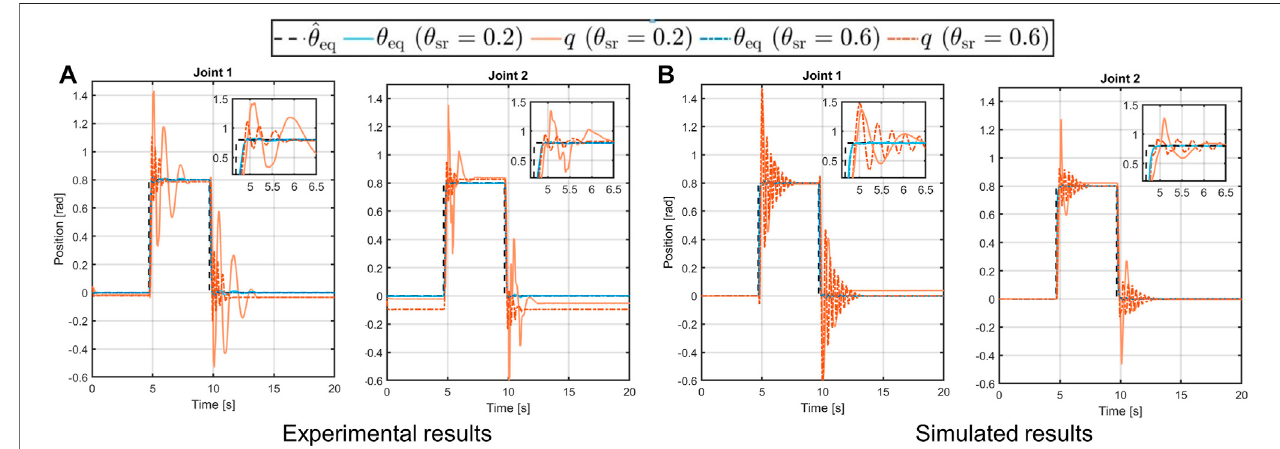
FIGURE 12 | Experimental [panel (A) ] and simulated [panel (B) ] results of the 2-DOF structure in horizontal con fi guration following step references with soft (solid lines) and stiff (dashed-dotted lines) behavior.